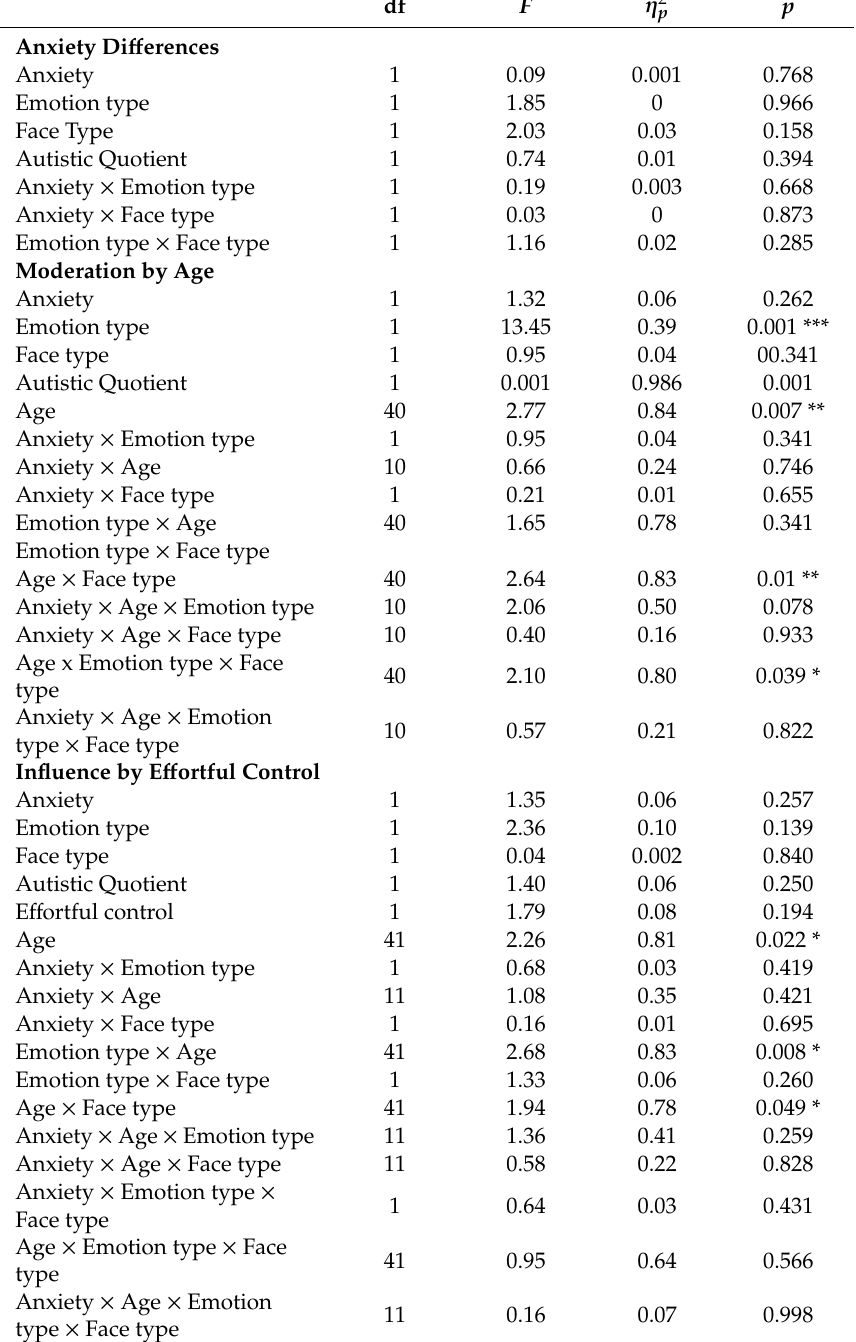
Table A2. Results of the mixed ANCOVAs for mean proportions of time spent looking at faces during Initial